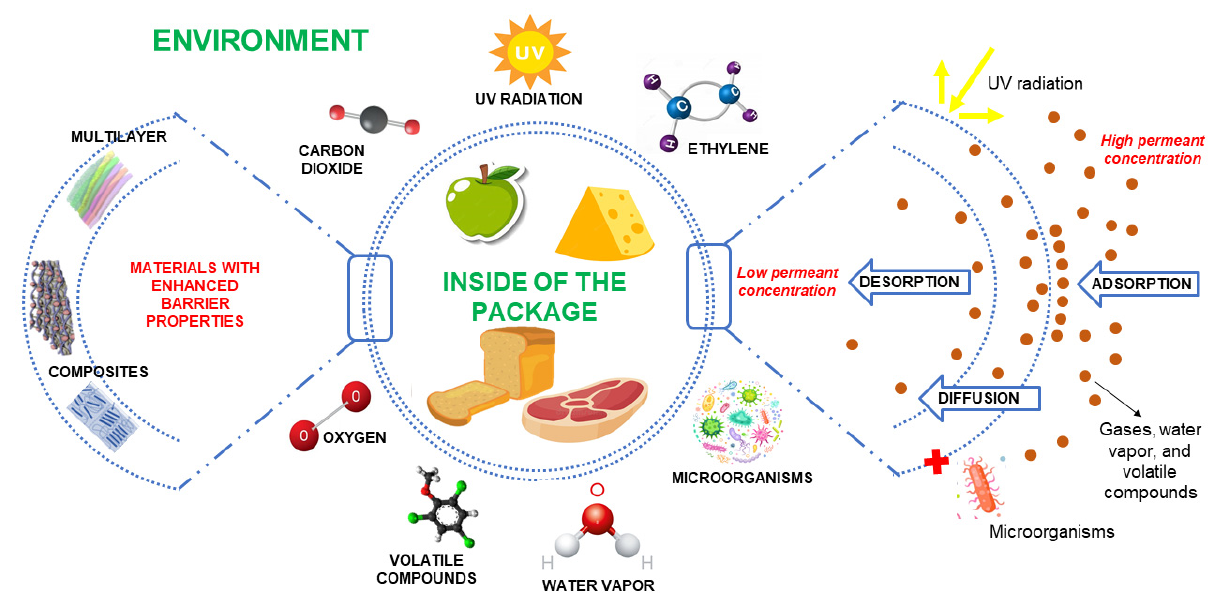
Figure 2. Barrier function of food packaging and hazardous agents for food safety present in the environment, along with some examples of enhanced barrier materials technologies.